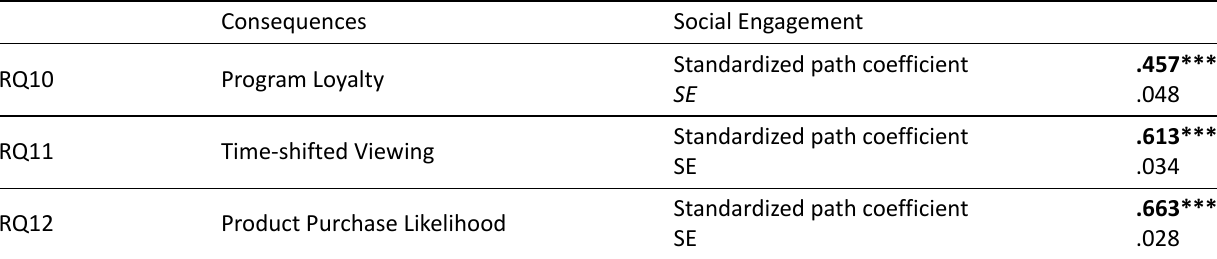
Table 3. Consequences of social